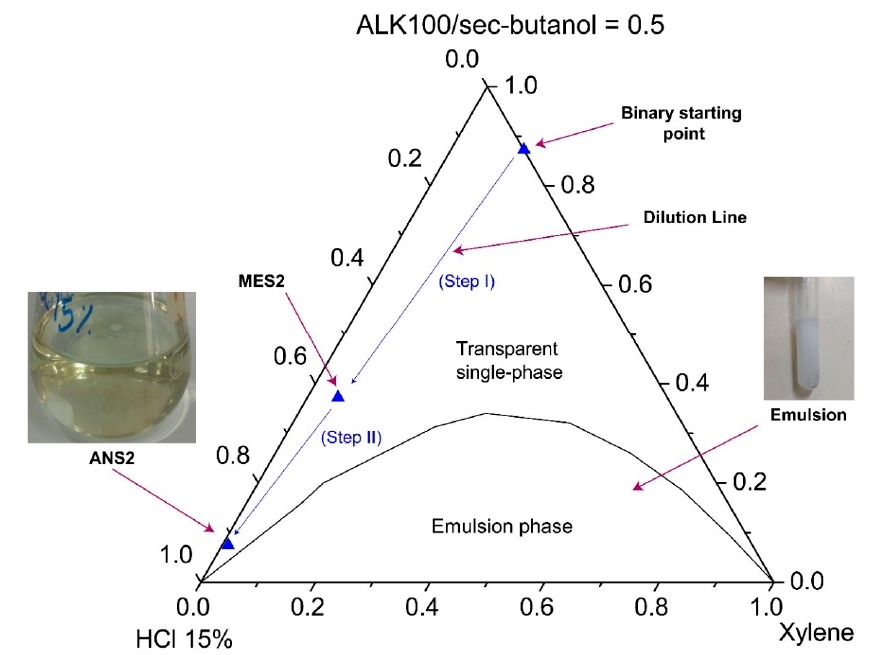
Figure 8. Phase diagrams for systems with ALK100.